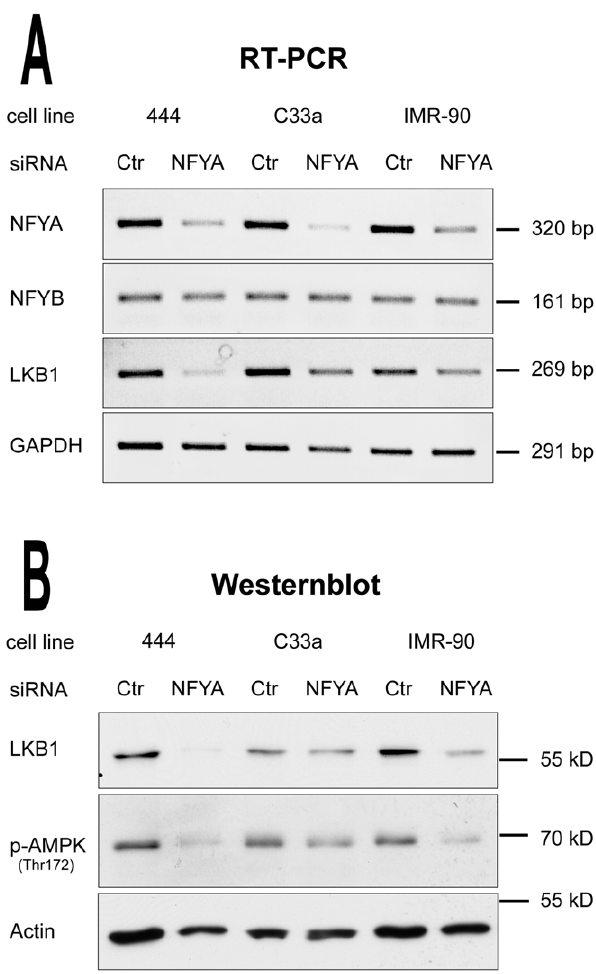
Figure 8. NF-Y a transcription factor is required for LKB1 gene expression. Knockdown of endogenous NF-Y a by siRNA inhibits LKB1 expression in ‘‘444’’, C33a and IMR-90 cells. Cells were transfected either with scrambled siRNA (Ctr) or with a siRNA targeting NF-Y a (NF-YA). Total RNA was purified and mRNA levels of NF-YA, NF-YB, LKB1 and GAPDH were analysed by RT-PCR using ethidium bromide staining ( A ). Equal amounts of total protein (5 m g) were separated by SDS-PAGE and analysed by western blotting using antibodies against LKB1, phospho- AMPK (Thr172) and actin ( B ). The data shown is representative of three independent experiments. doi:10.1371/journal.pone.0032590.g008 The 5 9 -flanking region of the LKB1 coding sequence encom- passing nucleotides 2 1536 to + 1321 relative to the transcription start site was amplified by PCR using 200 nM of forward (5 9 - CACCCTGCCTAATGTCCCTA-3 9 ) and reverse (5 9 -GAGTC- CAGCACCTCCTTCAC-3 9 ) primers, 2 ng/ m l of genomic DNA from ‘‘444’’ cells as a template and 0.05 U/ m l of PfuUltra HF DNA polymerase (Stratagene) in a final volume of 25 m l PfuUltra reaction buffer containing 0.1 mM dNTP’s, 4% of dimethylsulf- oxide and 2% of formamide. The PCR-product was purified, cloned into the pJET1.2 plasmid using the CloneJET PCR Cloning Kit (Fermentas) according to the manufacturer’s instruc- tions and verified by DNA sequencing. The LKB1 promoter (position 2 1536 to + 727) was then subcloned into the SmaI site of the pGL3-Basic luciferase reporter vector by PCR amplification using the same forward primer and the reverse primer (5 9 -